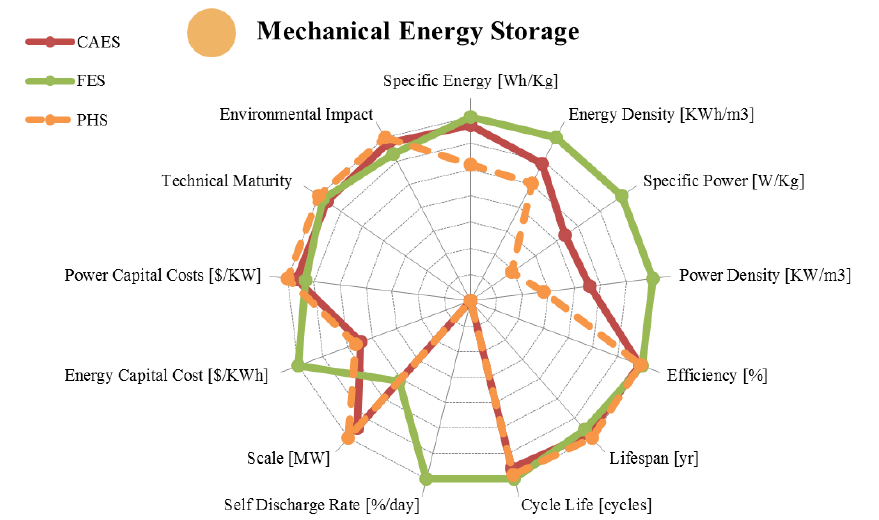
Figure 4. Comparing mechanical energy storage using normalized and logarithmically plotted average data from Table 3. PHS, shown as a dashed line is used as a basis of comparison for all other energy storage